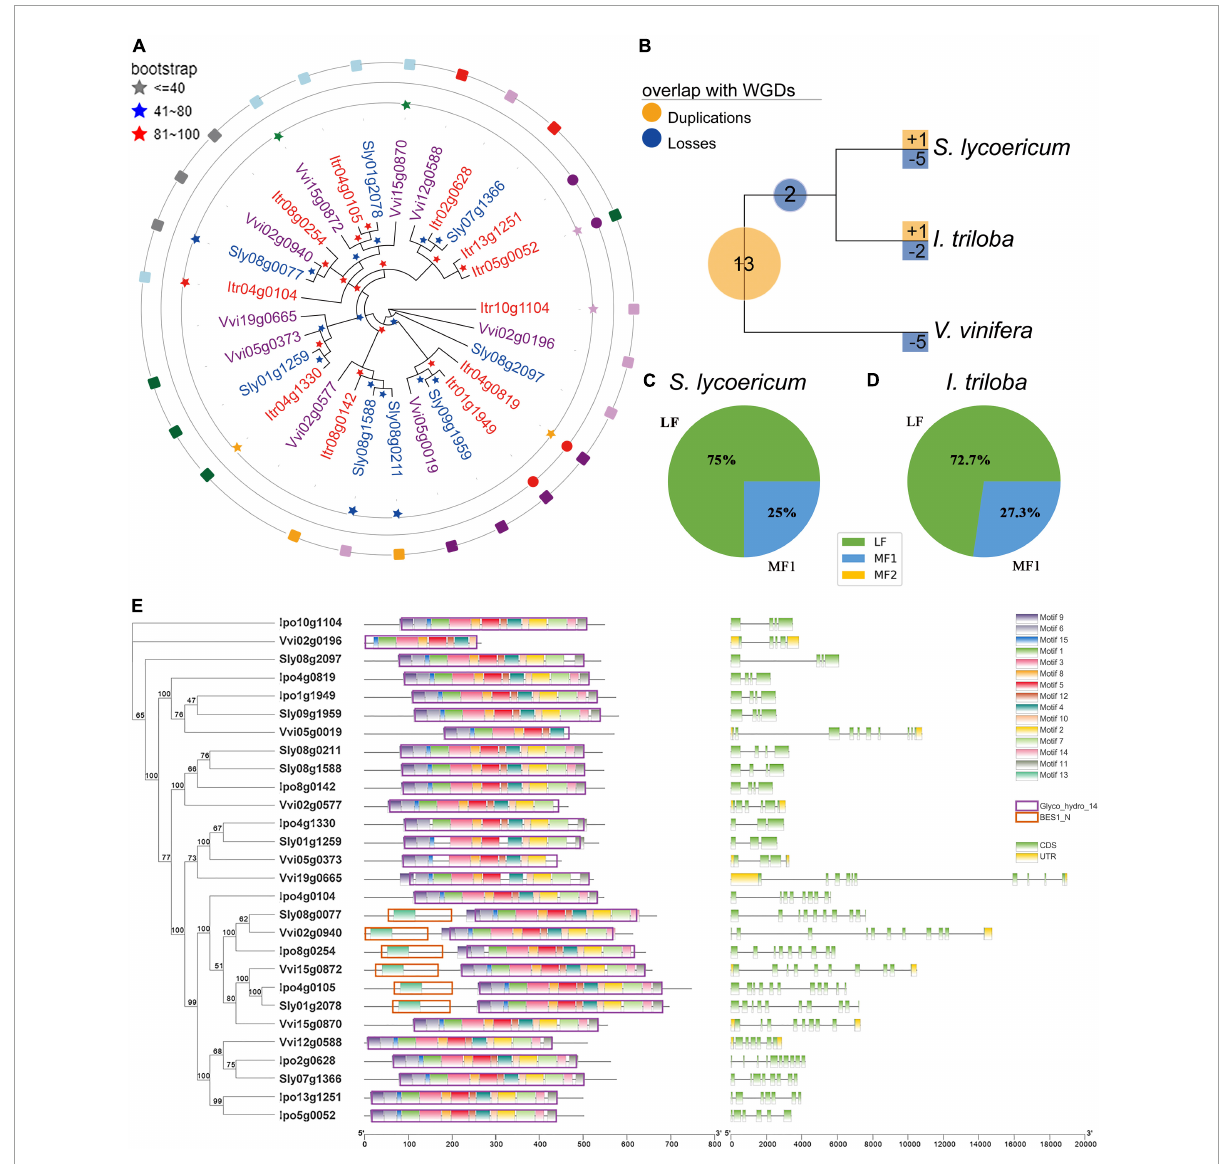
FIGURE5 Evolution and structural diversification of β -amylase (BMY) genes in the studied genomes. (A) Phylogenetic tree of BMY genes. The bootstrap values that indicate the credibility levels of the structures are shown by the different color stars. The genes with different colors belong to different species, the three circles are located represent the different relationships between genes (inner to outer: paralogous, paralogous, and orthologous respectively), the same color or the same shape in the same circle represents the same kind of relationship. (B) Gene duplications and losses at different periods along the evolutionary history of studied genomes. (C) Distribution of BMY genes in each of the three subgenomes [least fractionated region (LF), moderately fractionated region (MF1), and most fractionated region (MF2)] within Solanum lycopersicum . (D) Distribution of BMY genes in each of the three subgenomes (LF, MF1, and MF2) within Ipomoea triloba . (E) Structural [motif, domain, coding sequence (CDS), and untranslated region (UTR)] distribution of BMY family members. The unit used for motifs 1–15 and domains (Glyco_hydro_14 and BES1_N) was amino acid, and the unit used for CDSs and UTRs was bp. WGD, whole-genome